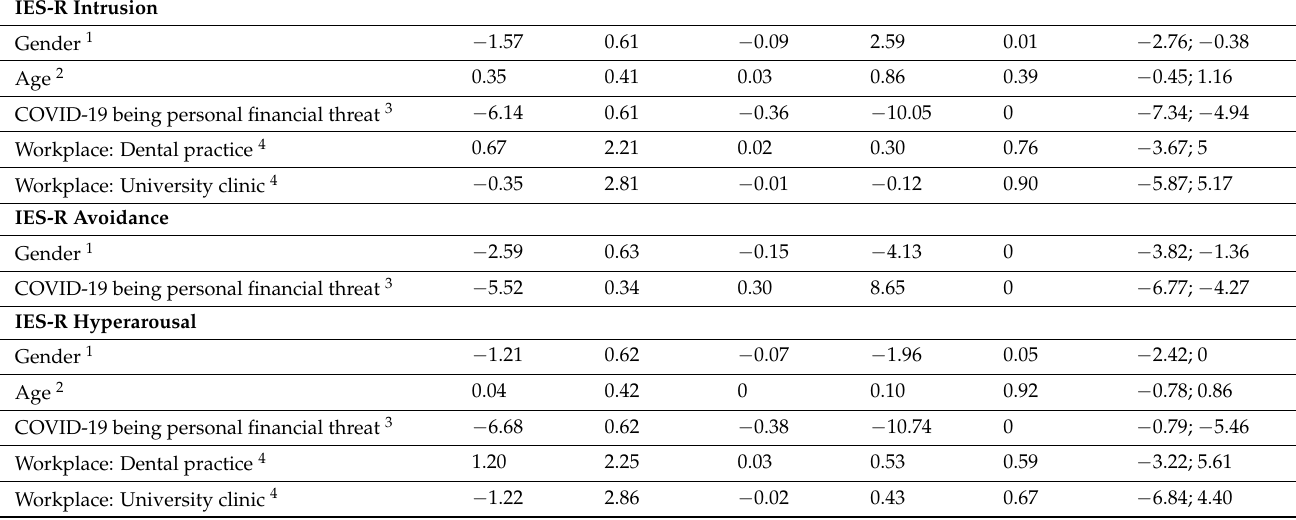
Table 7. Multiple regression analyses with relevant factors of IES-R